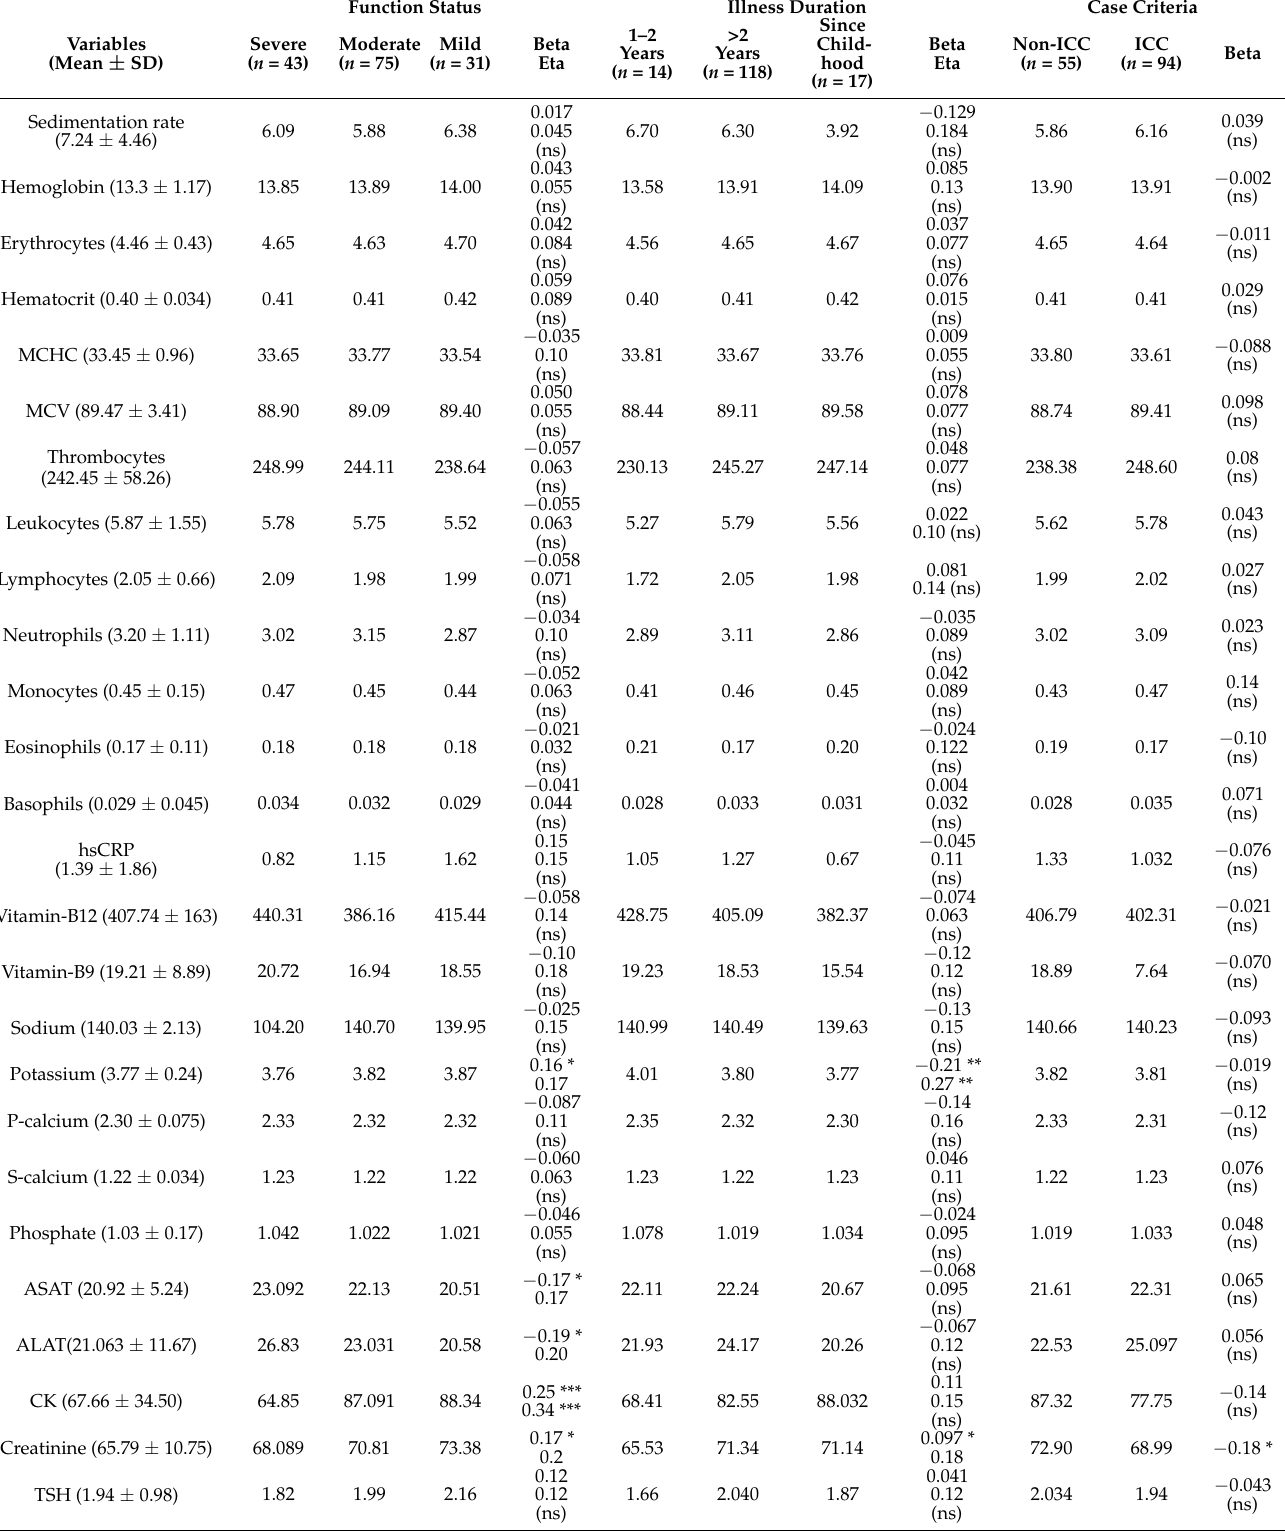
Table 3. Comparison of baseline mean scores for routine blood tests among ME/CFS patients based on functional status assessment, illness duration, and case criteria for ME/CFS among